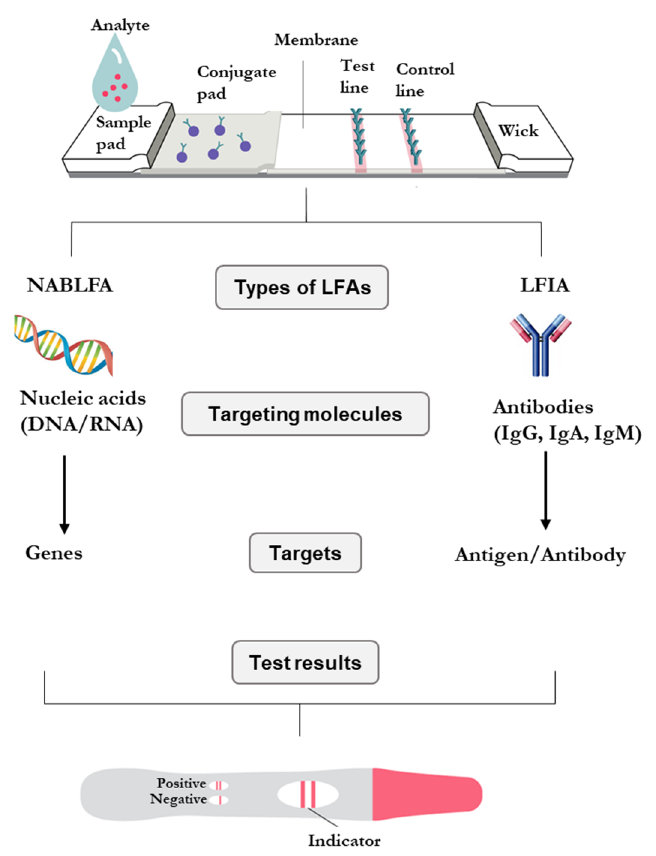
Figure 1. Types of clinically used LFAs for detection of nucleic acids (NABLFA) and antibodies (LFIA) found in biological fluids. Adapted with permission from [90]. 2021, MDPI.